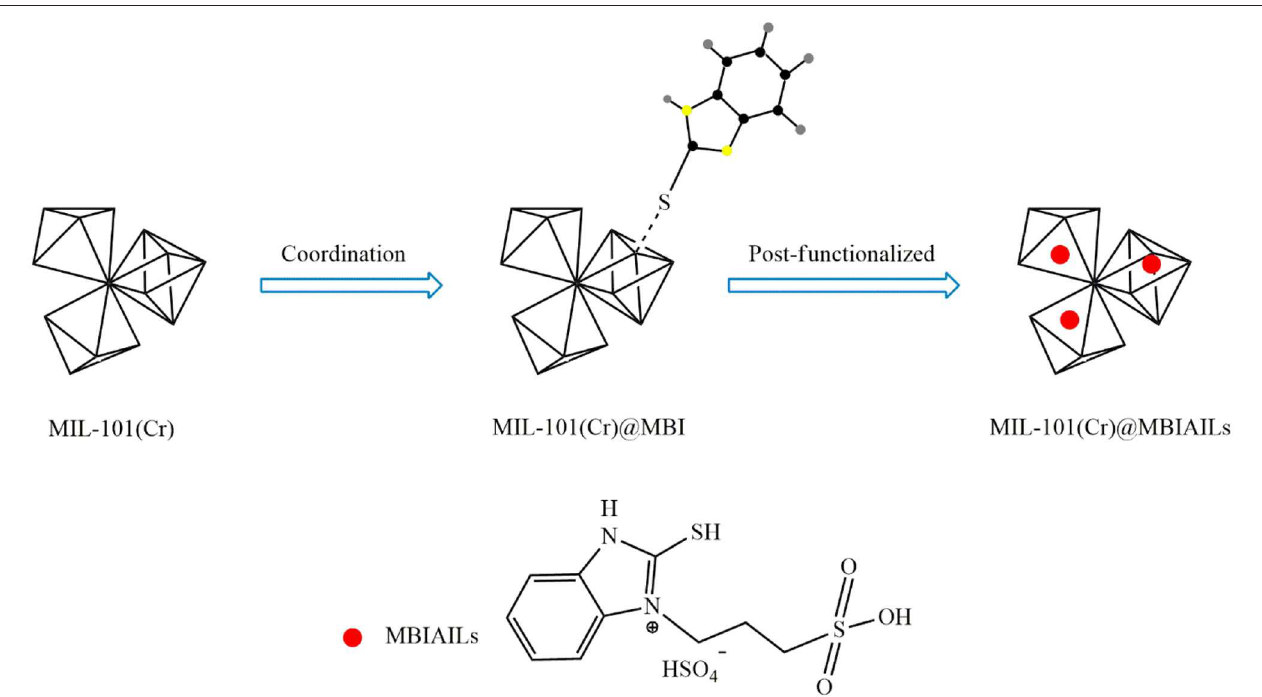
FIGURE 7 | Synthesis process for MIL-101(Cr)@[SO 3 H-(CH 2 ) 3 -HMBI][HSO 4 ] [Redrawn with modification from Han et al. (2018)].